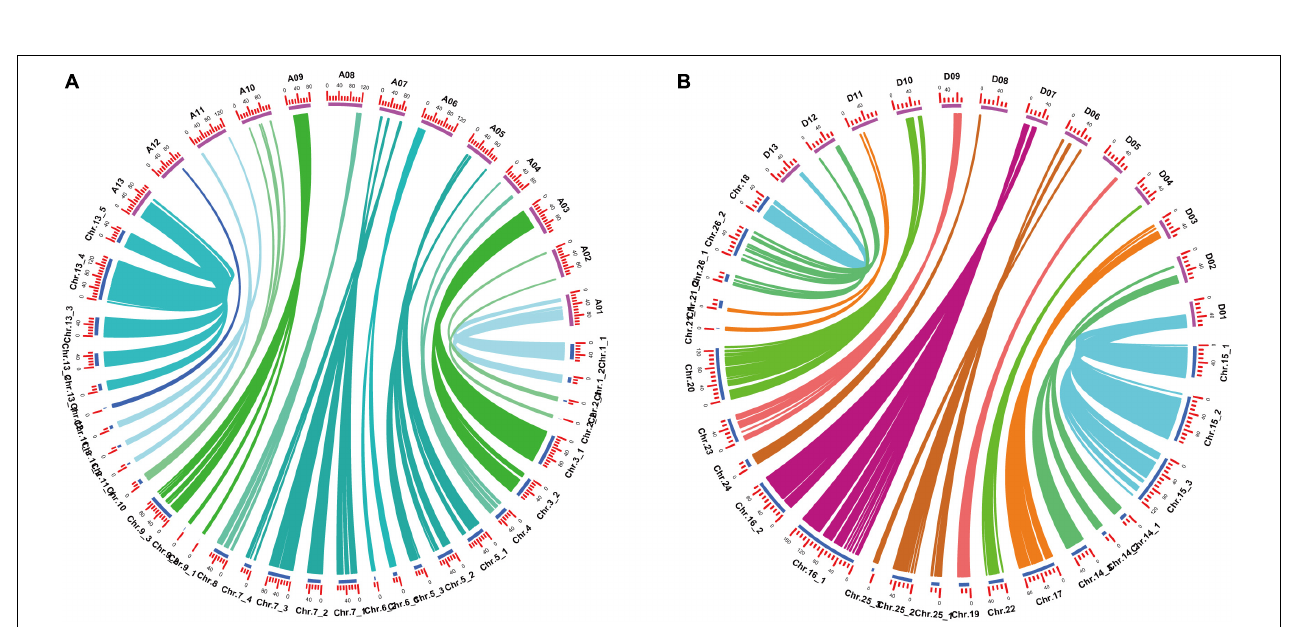
FIGURE 2 | Collinearity analysis of genetic map and physical map. (A) A subgenomic chromosome collinearity. (B) D subgenomic chromosome collinearity.